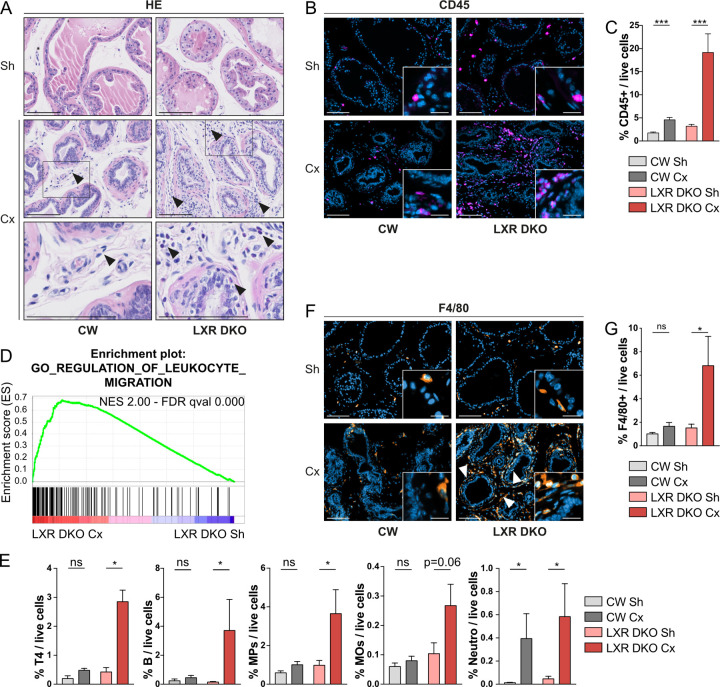
Androgen deprivation-induced immune infiltration in LXR-null prostates is composed of a majority of F4/80+ macrophages.(A) Hematoxylin and eosin staining of prostates from 1-month Cx or Sh male CW and LXR DKO mice. Arrowheads indicate immune cells infiltration. (B) Immunohistological staining of the pan-leucocytes marker CD45 in 1-month Cx or Sh CW and LXR DKO prostates. (C) Flow cytometry analysis of CD45+ leucocytes representation in whole prostates. (D) Gene ontology analysis of RNA sequencing reveals enrichment in regulation of leukocyte migration gene set, after 1 month of castration in LXR DKO mice. (E) Castration of LXR DKO mice induces a marked increase in infiltration of T4 lymphocytes, B cells, MPs, and MOs in comparison to CW mice. CD45+ immune cells were defined as: CD4+ T4 lymphocytes, CD19+ B cells, CD11b+ Ly6C− Ly6G− F4/80+ SCClow MOs, CD11b+ Ly6C− Ly6G− F4/80− and CD11b− CD11c− F4/80+ other MPs, and CD11b+ Ly6C− Ly6G+ neutro. (F and G) Immunohistological staining (F) and flow cytometry analysis (G) of F4/80+ MOs representation in 1-month Cx or Sh CW and LXR DKO prostates. Groups are composed of at least 4 animals. Bars represent mean ± SEM. Statistical analyses were performed via Mann–Whitney test. *p < 0.05, **p < 0.01, ***p < 0.001 and ns. Scale bars, 100 μm; insets, 20 μm. For numerical raw data, please see S1 Data. For supporting dataset, please see S2–S4 Datas. For flow cytometry raw data, please see S1 FlowCytometry RawDataFCS. Cx, castrated; CW, control wild-type; LXR, liver X receptor; LXR DKO, LXR alpha and beta double knock-out; MOs, macrophages; MPs, mononuclear phagocytes; neutro, neutrophils; ns, nonsignificant; Sh, sham-operated.